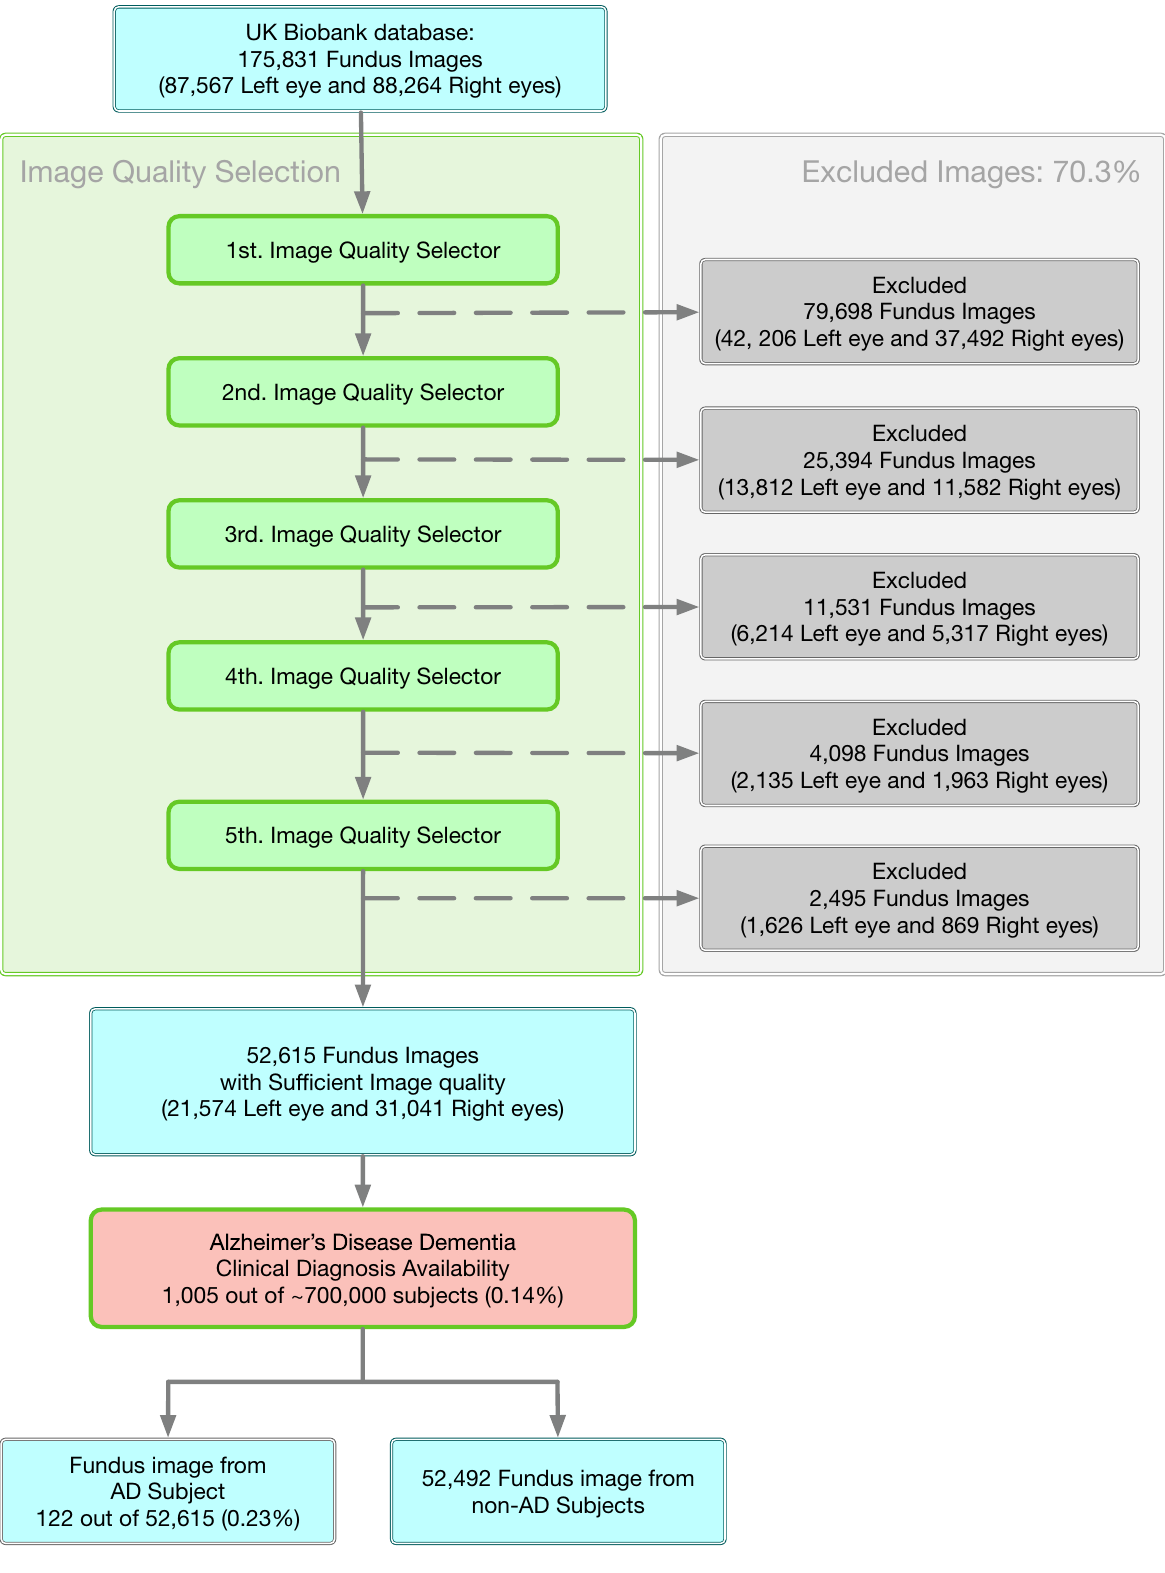
Figure 3. Database selection rate flow. The five selectors are cascaded, meaning one image is considered to be a sufficient image only if it passes all five selectors. We have a database containing 122 fundus images from 87 AD